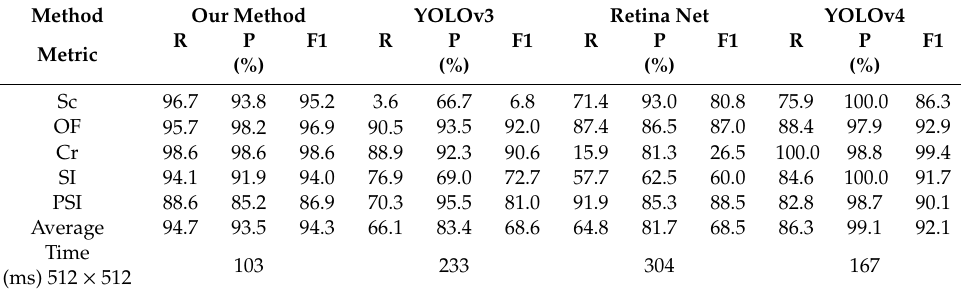
Table 4. Performance comparison of the four methods for each type of defect.